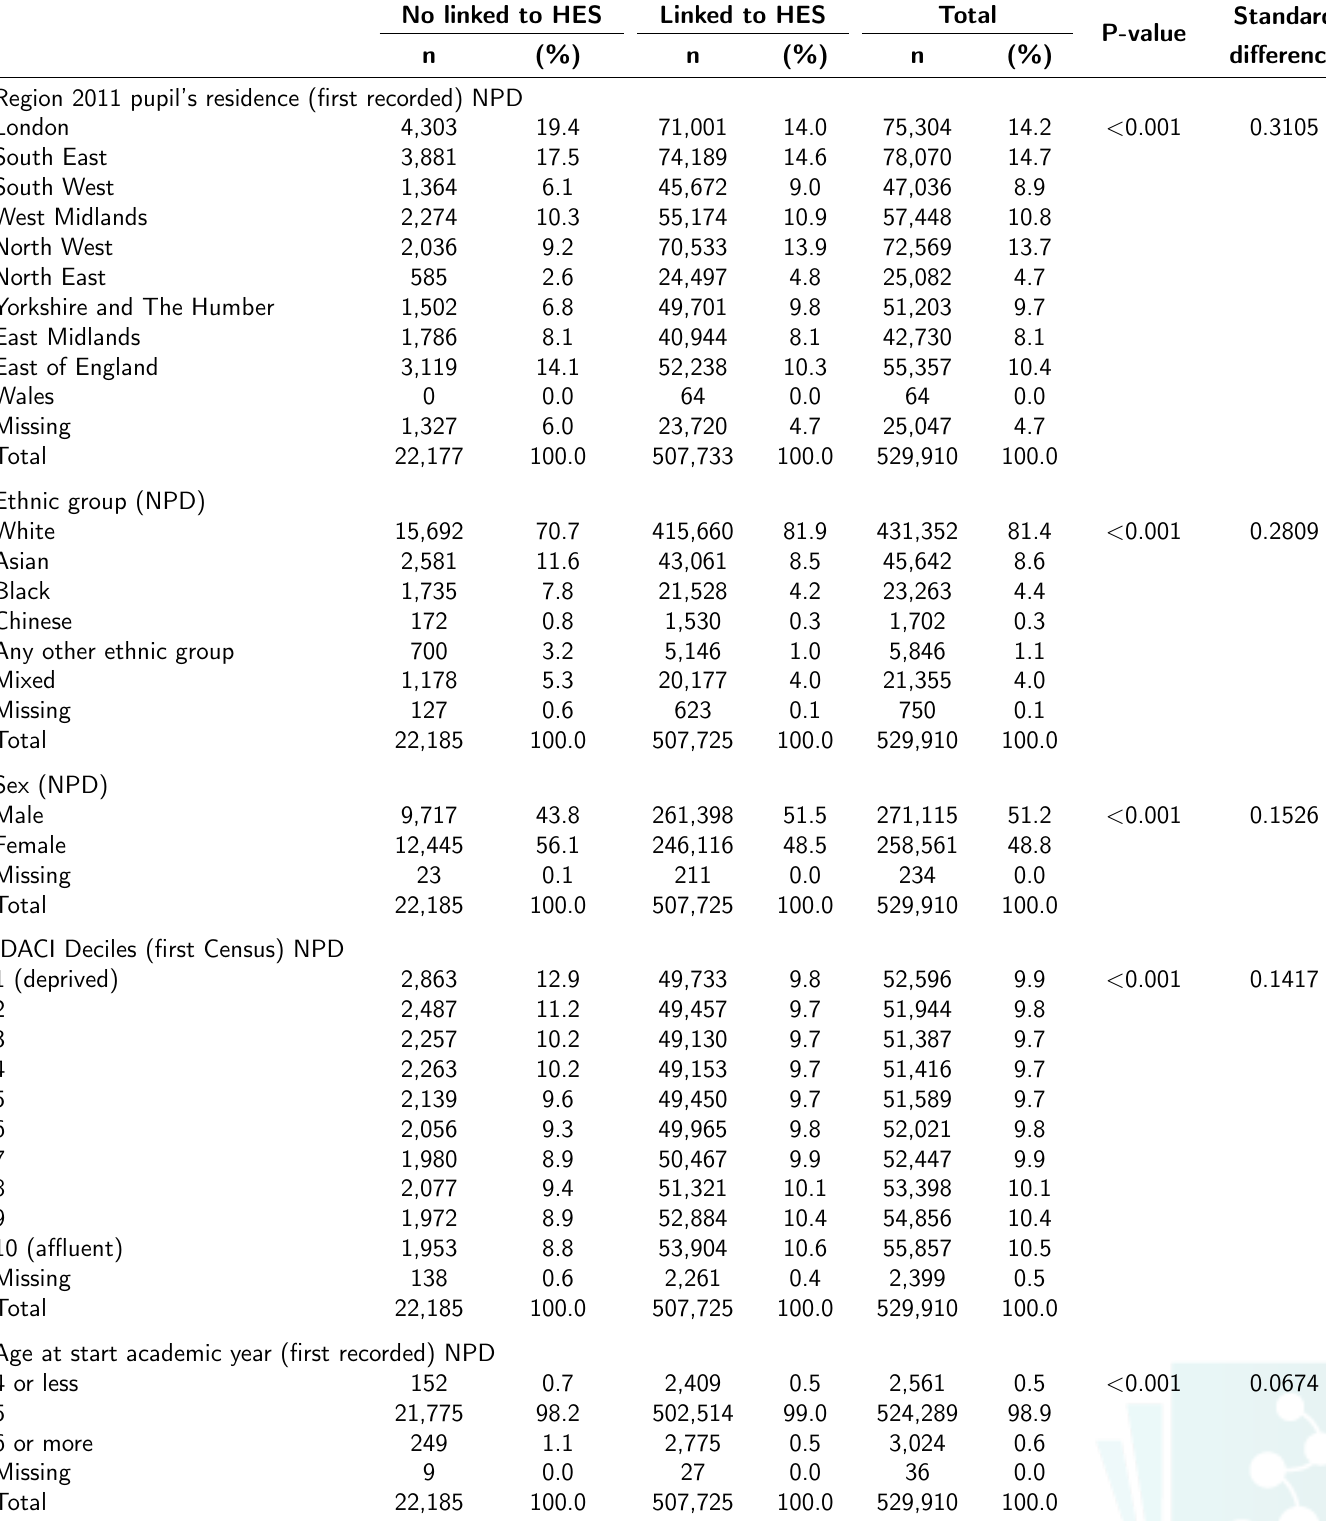
Supplementary Table 9.3: Distribution of demographic variables in national pupil dataset by linking status, N = 529,910 pairs (national pupil dataset to hospital episode statistics). Cohort